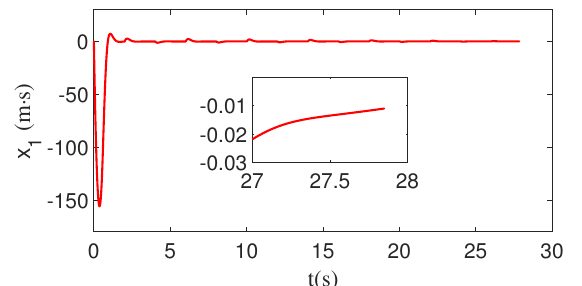
Figure 12. The change of the integral of ZEM with square wave maneuver.